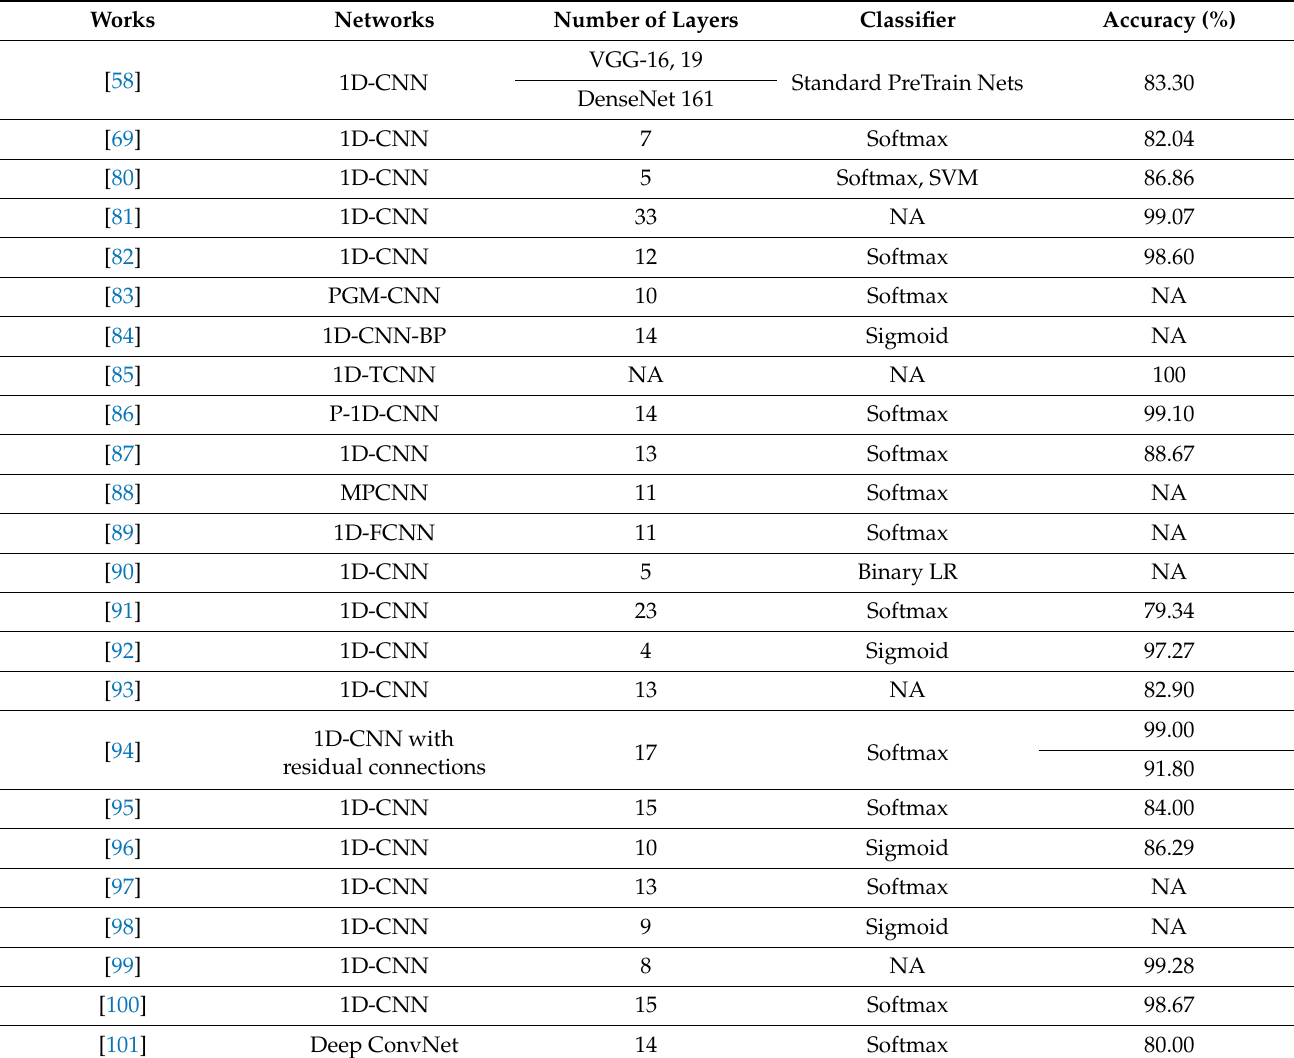
Table 3. Summary of related works done using